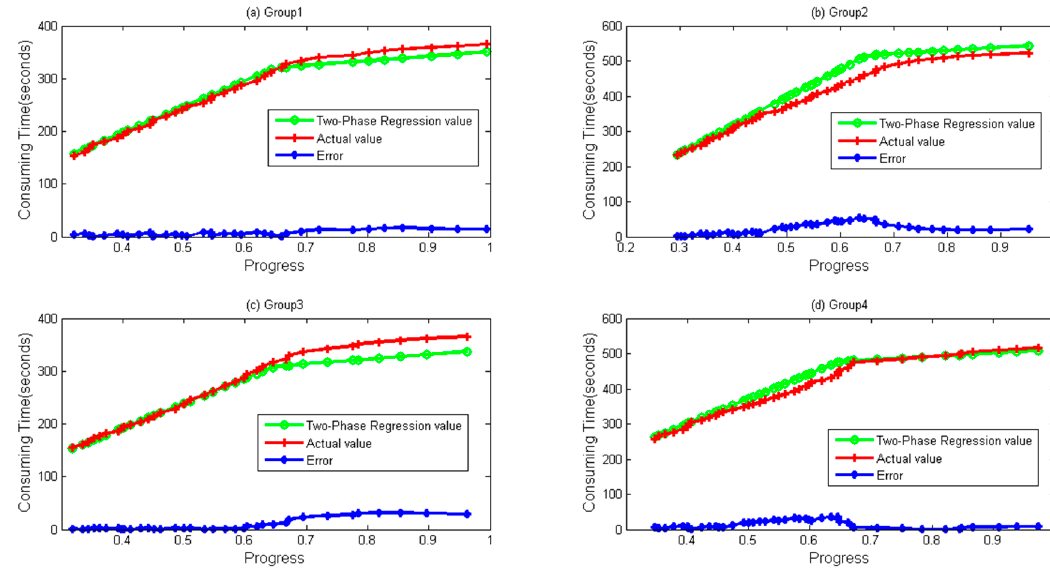
Figure 7. Two-Phase Regression values. Error obtained by Abs (Regression Value – Actual value). ( a ) Group 1; ( b ) Group 2; ( c ) Group 3; and ( d ) Group 4 data and their values calculated by Two-Phase Regression for WordCount sample.